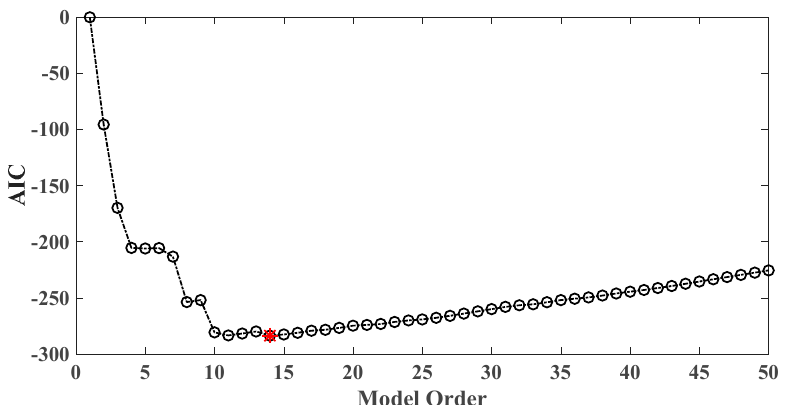
Figure 19. AIC of an AR model for the third floor response under the case of level 2 damage occurring on the third floor.